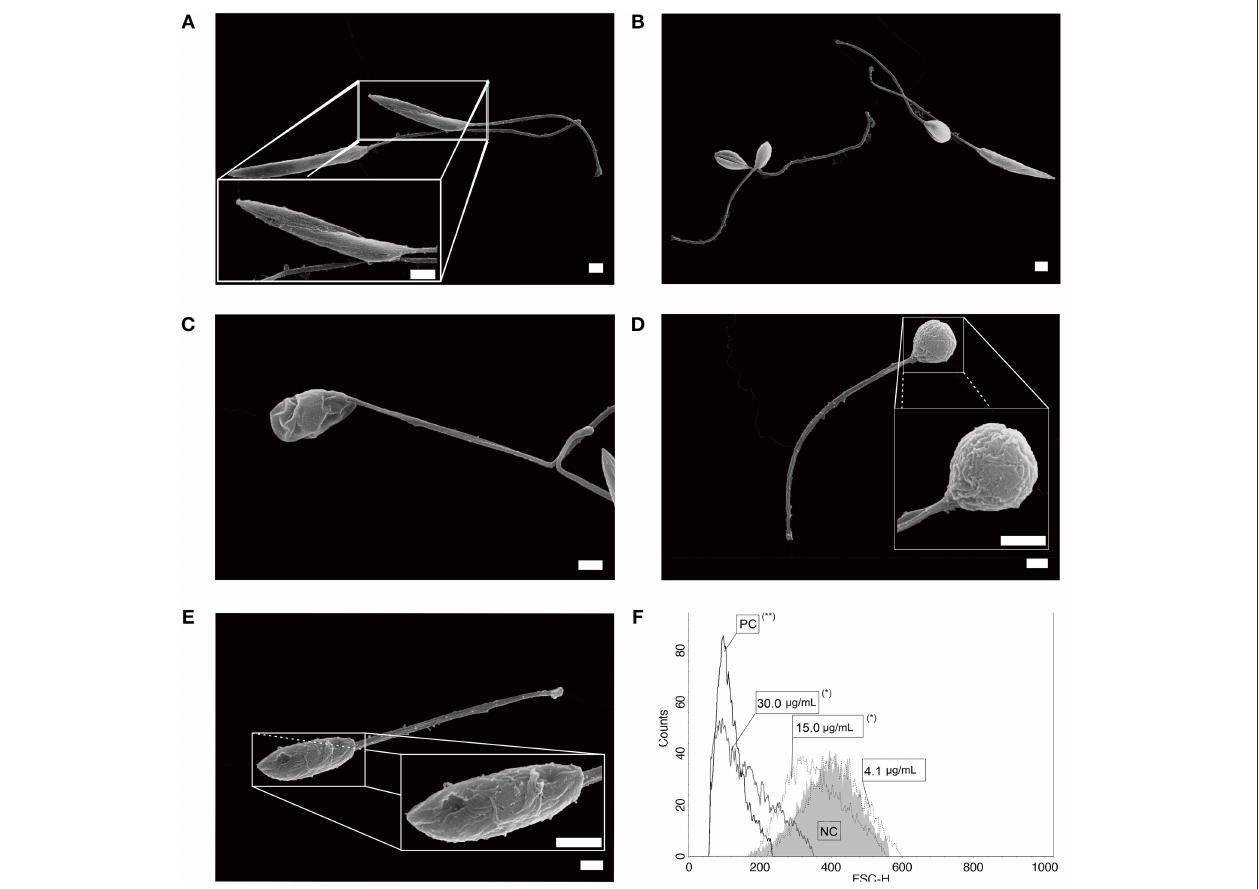
FIGURE 1 | L. infantum promastigotes observed on SEM. (A) non-treated parasites; (B,C) parasites after 72h of incubation with 4.1 µ g/mL of sugiol, representing the IC 50, and (D,E) with 30.0 µ g/mL of sugiol (scale bar = 1 µ m). Cell size was evaluated by flow cytometry after treatment with different concentrations of sugiol, according to the histogram (F) . Miltefosine at 16.0 µ g/mL was used as positive control. * p < 0.05 and ** p < 0.01, significant difference compared with negative control (NC)